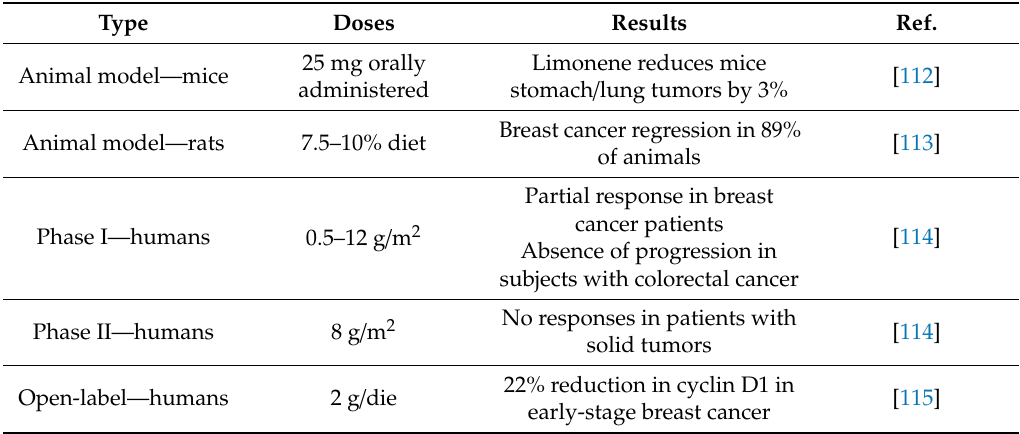
Table 4. Summary of findings of clinical studies and preclinical experiments with animal models about anti-proliferative e ff ects of